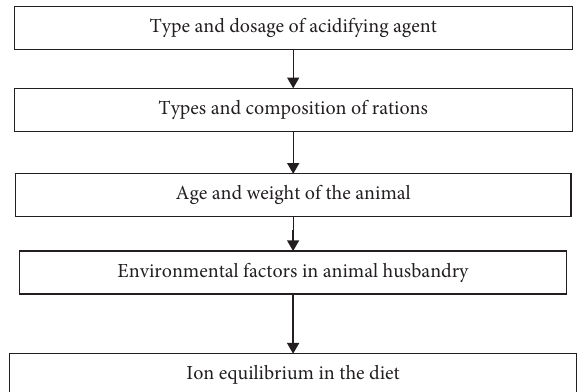
Figure 1: Flow charts affecting acidification